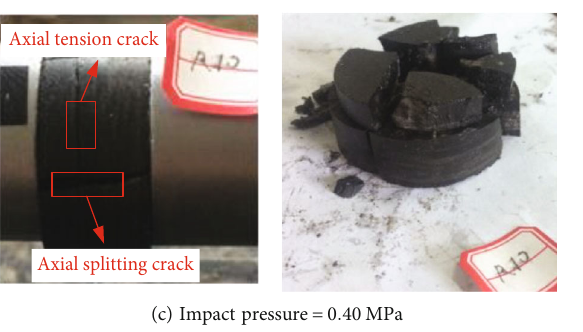
Figure 8: Crack morphology of mudstone under di ff erent impact